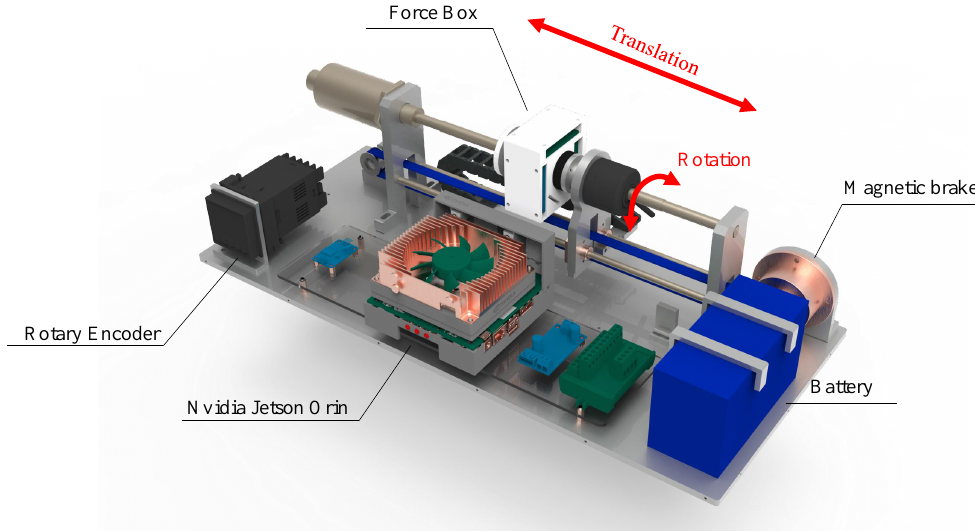
Figure 3. Model of the surgeons’ manipulator for vascular intervention.